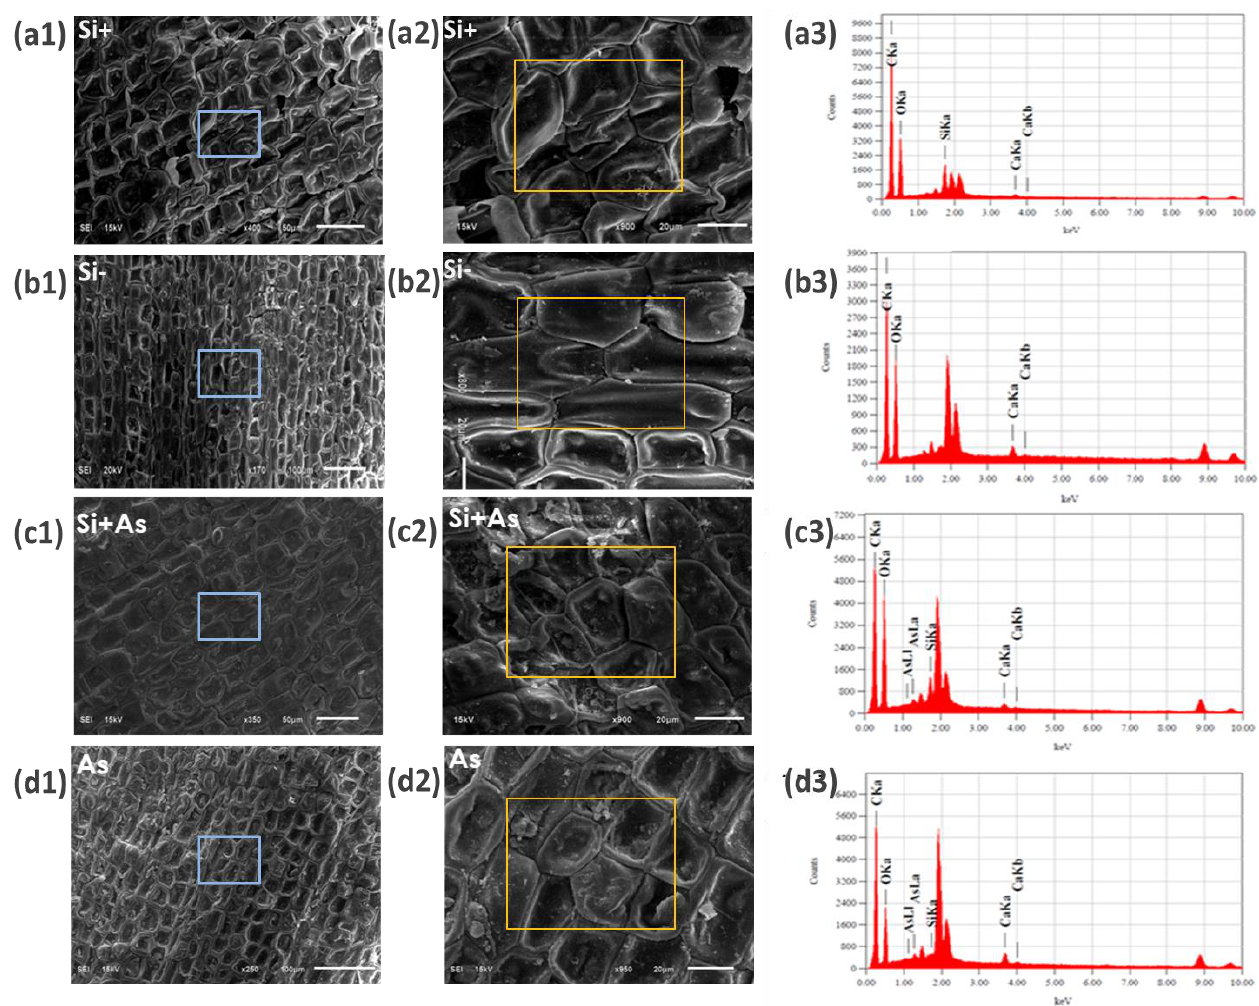
Figure 9. Scanning electron microscopy (SEM) images of date palm roots under different treatments of non-silicon (Si-), silicon (Si+), combined (Si + As), and arsenic (As). Images ( a1 , a2 , b1 , b2 , c1 , c2 , d1 , d2 ) represent morphological variations and element granules (circled blue and yellow), respectively, for Si+, Si-, Si + As, and As. The encircled areas in yellow were selected for EDS-based elemental analysis ( a3 ) showing EDX-elemental peaks for Si-treated samples, ( b3 ) (Si-), ( c3 ) (Si + As), and ( d3 ) represent data for As-treated plants, respectively. Three biological replicates were screened for each sample.